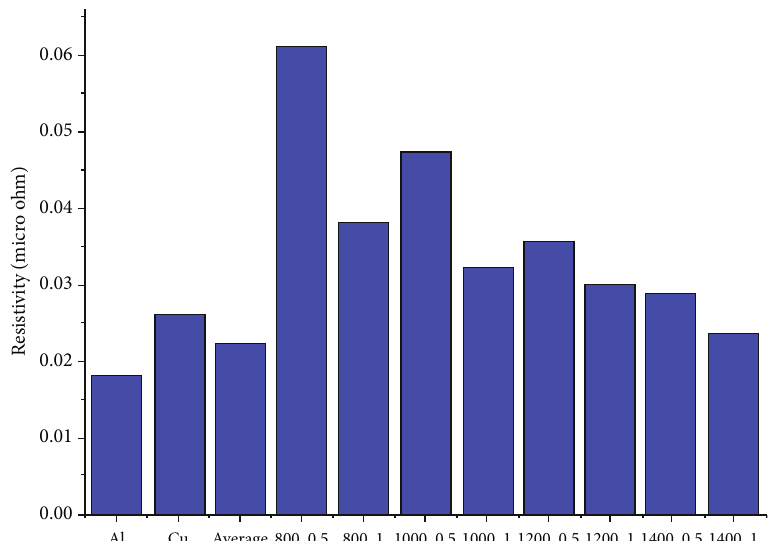
Figure 7: In fl uence of process parameters on the electrical resistivity of the spot welds when compared to the base metals and their average